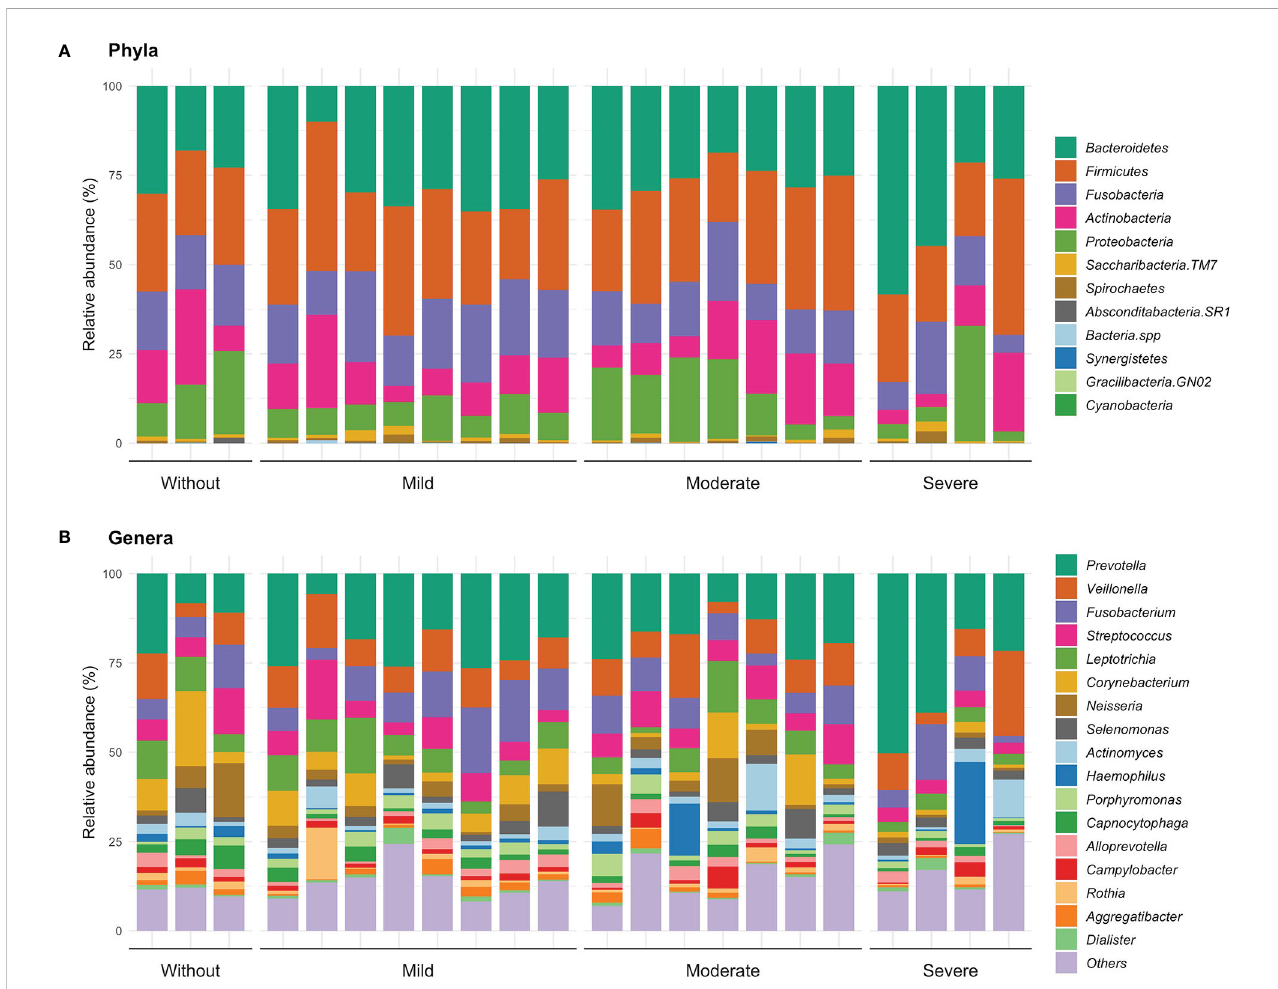
FIGURE 3 Relative abundance at phyla (A) and genera level (B) according the in fl ammation-based risk scoring system. In this same fi gure, the category of “ others ” is identi fi ed, where the identi fi ed genders are grouped in a proportion of less than